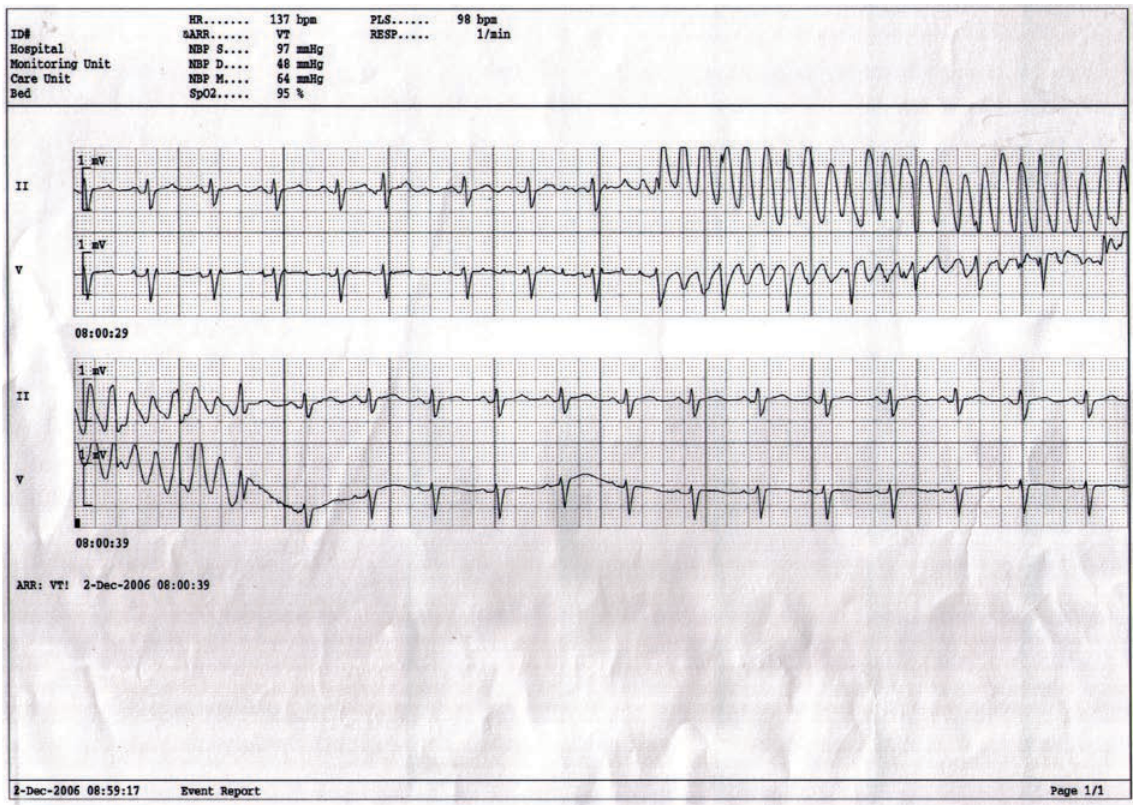
Figure 1. Wide complex tachycardia runs consistent with polymorphic ventricular